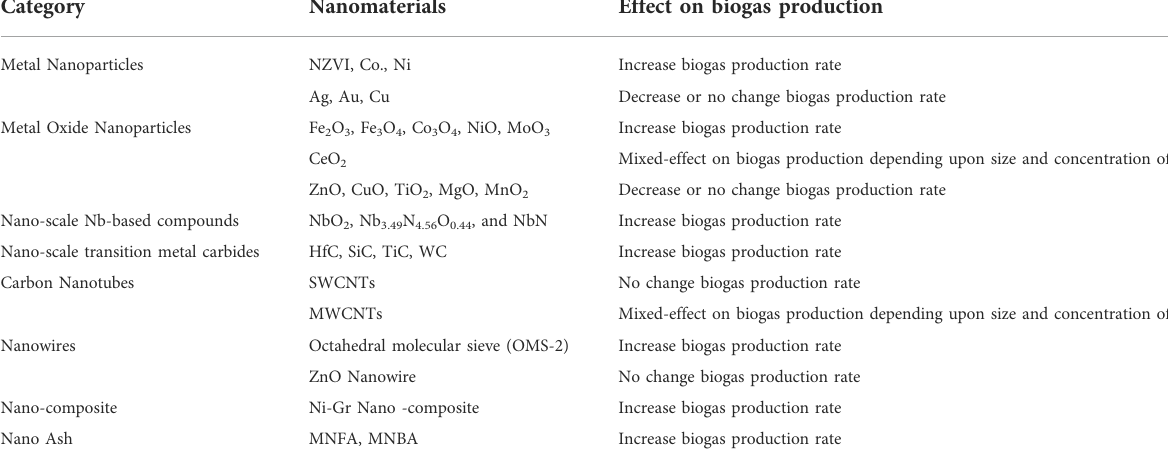
TABLE 8 Reported nanomaterials and their in fl uence on biogas